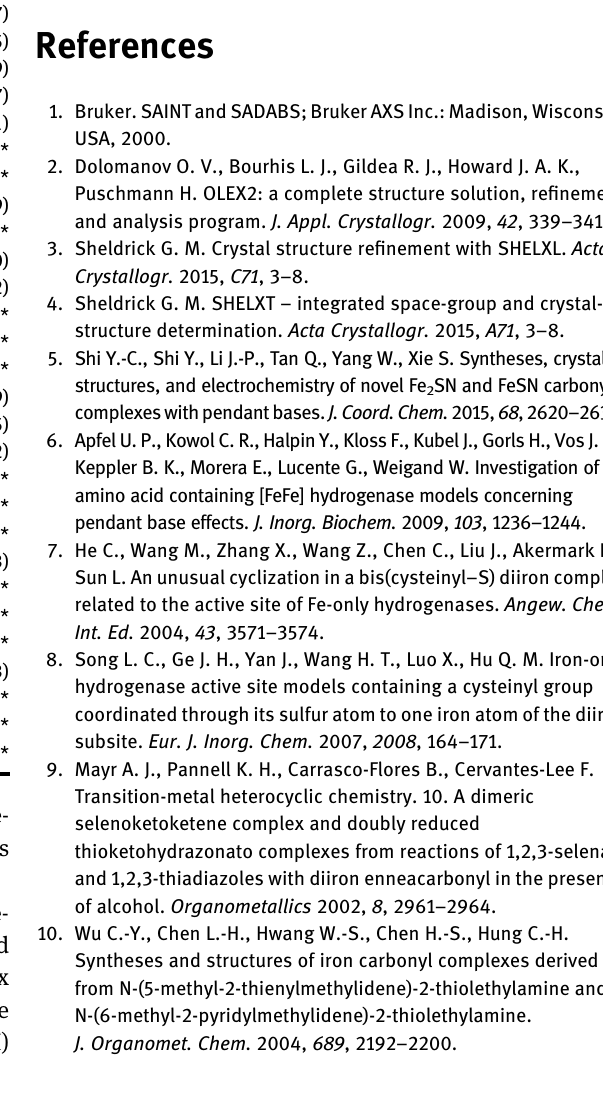
ion is six-coordinated with N1, S1, Fe2 and three carbonyl groups. The Fe1 – S1 and Fe1 – N1 bond distances are 2.2423(12) and 1.991(3) Å, respectively. Notably, a Fe – Fe bond can be found in the [Fe L(CO) ] unit, the Fe1 – Fe2 2 6 bond distance is 2.4311(9) Å, agreeing well with the pub- lished Fe-complexes including similar coordination envi- ronment [9, 10].